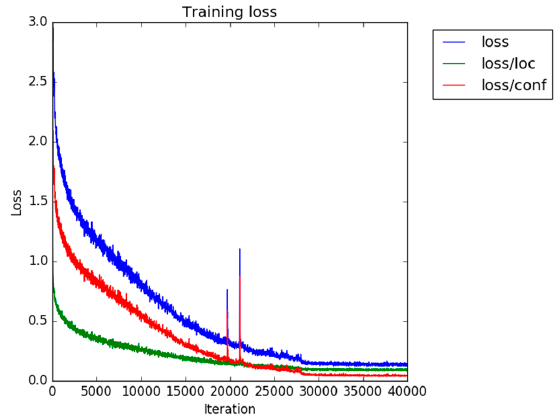
Figure 8. SSD training curve with the Dataset S_train. “Loss” represents L SSD , which is the sum of the localization loss (“loss/loc”) and the classification loss (“loss/conf”).